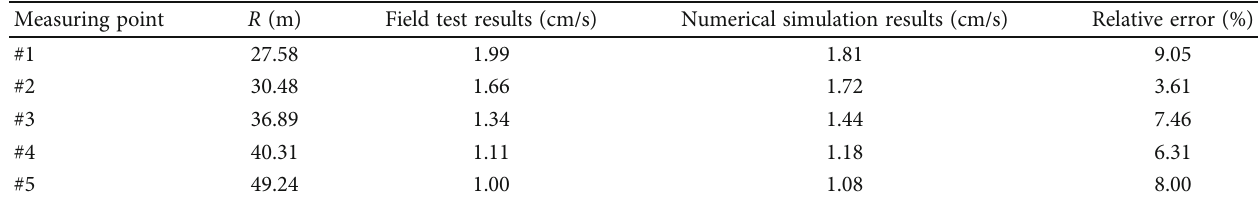
Table 4: The comparison between the numerical calculation results and the experimental results. Measuring